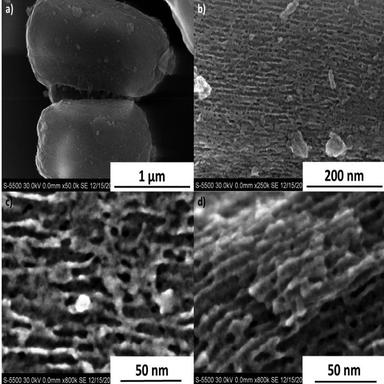
HR-SEM images of S(100)48-PS-30 composite material (views at different magnifications and locations).